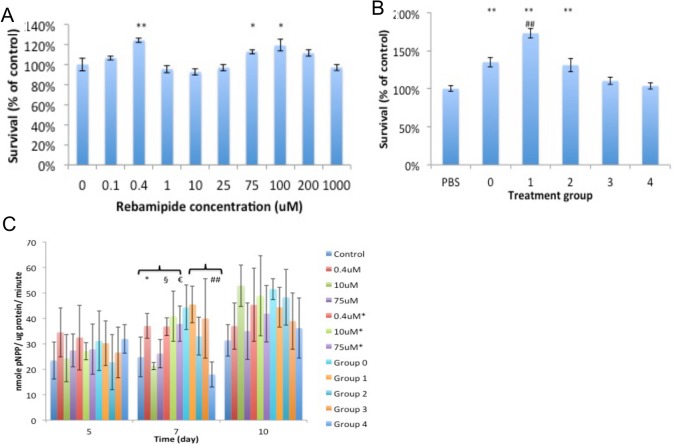
Osteoblast proliferation and differentiation.Rebamipide stimulates proliferation of osteoblasts at 0.4uM after acute (24 hours) exposure (A) (* and # indicate p< 0.05, ** and ## indicate P<0.01 when compared to untreated control, or group 0 for leach respectively, Dunnet’s t-test). The leach from control cements and Rebamipide loaded cements stimulated proliferation (B) (** indicate P<0.01 when compared to untreated control, ## indicate P<0.01 when compared to group 0 leach, Dunnet’s t-test). In differentiating osteoblasts Rebamipide exposure did not affect ALP activity, except at day 5 in 0.4uM treated samples (C) (+ (0.4uM), @ (10uM), § (0.4uM*), € (75*uM) indicate p< 0.05 compared to control, ## (group 5) indicate P<0.01 when compared to group 0 leach, Dunnet’s t-test). In the legend, concentrations with * indicate that the same concentration of Rebamipide was added at every media replacement (constant).